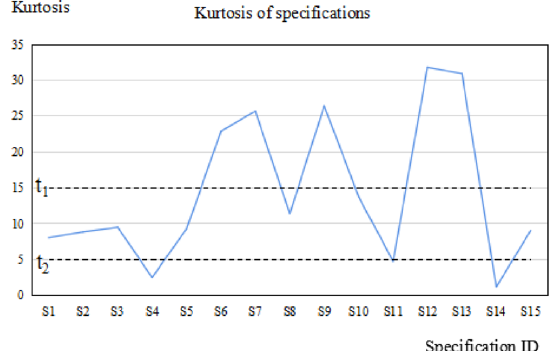
Figure 9 Kurtosis of all